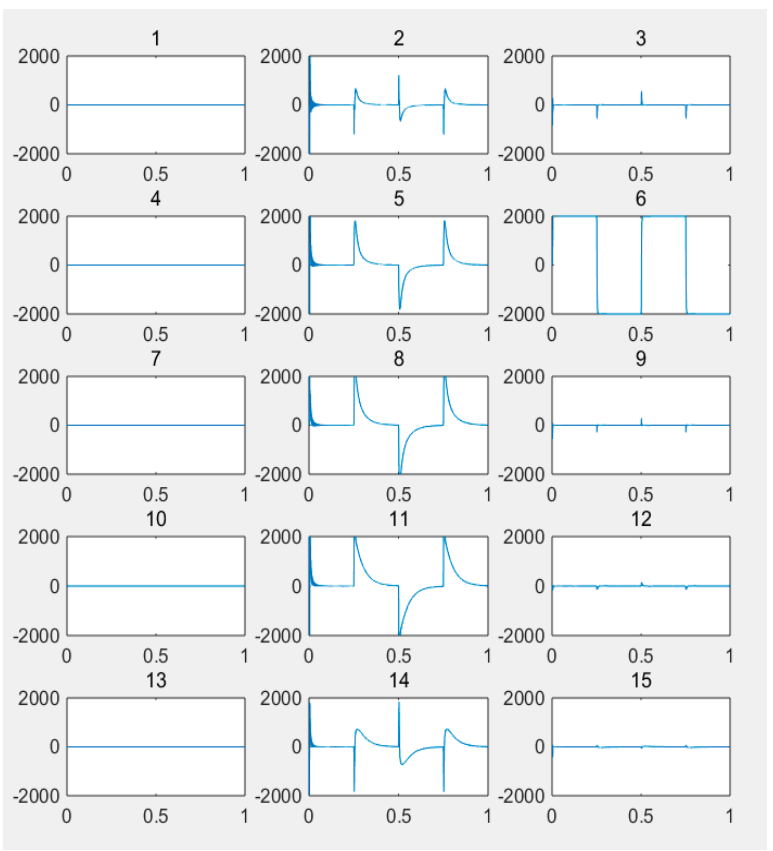
Figure 10. Location estimation of triangular force ( Q w = 1 × 10 − 8 , σ = 1 × 10 − 16 ) .